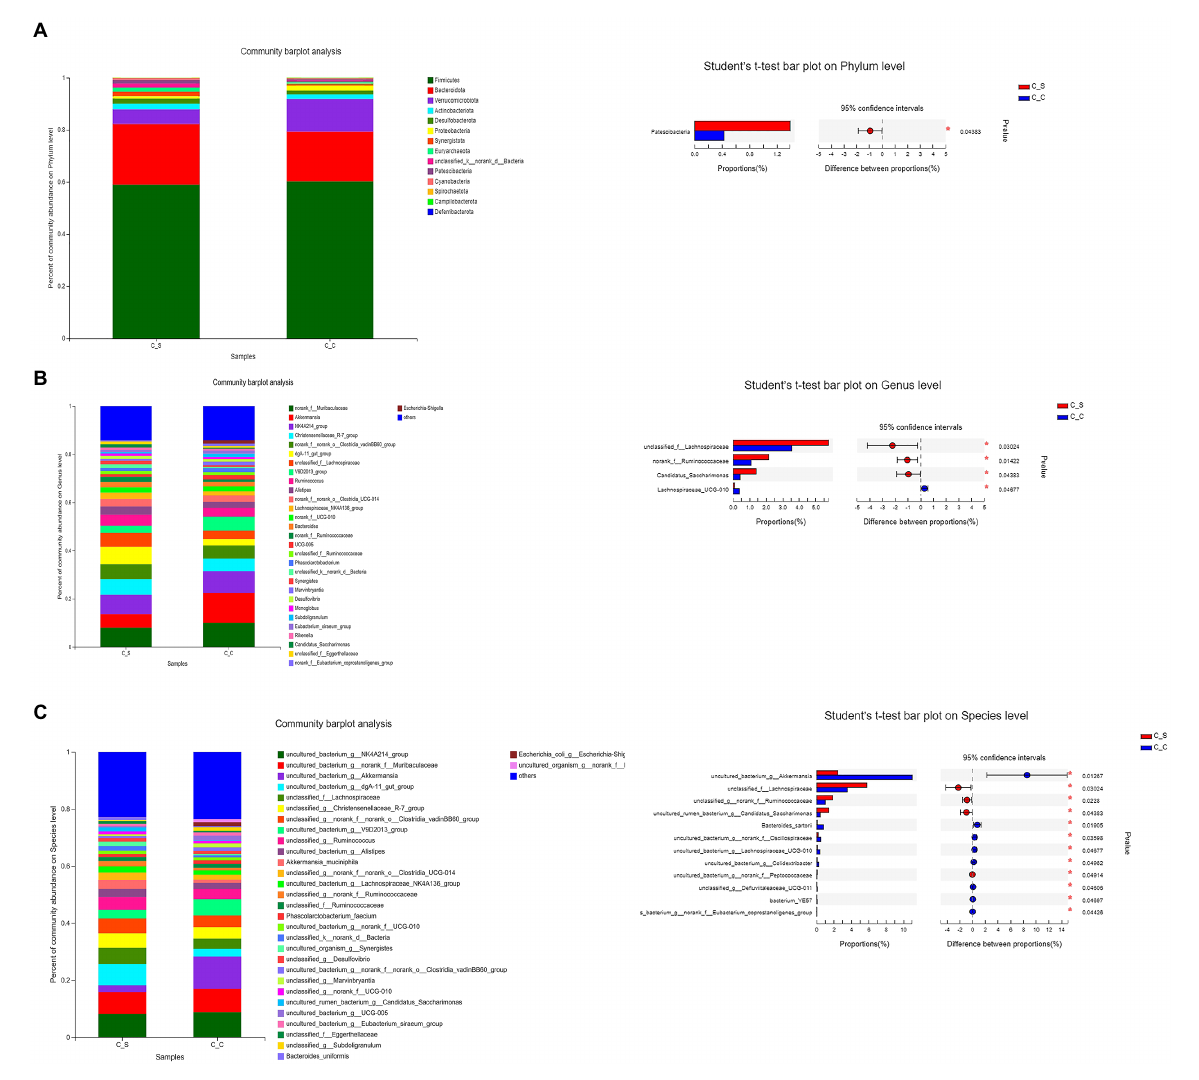
FIGURE 9 Effects of stress on cecum bacterial in meat rabbits. Relative abundance of species and between-group difference tests at different species taxonomy levels ( A :Phylum level, B :Genus level, C :Species level). In the figure, C ▬ S represents the HT group and C ▬ C represents the appropriate temperature group, n